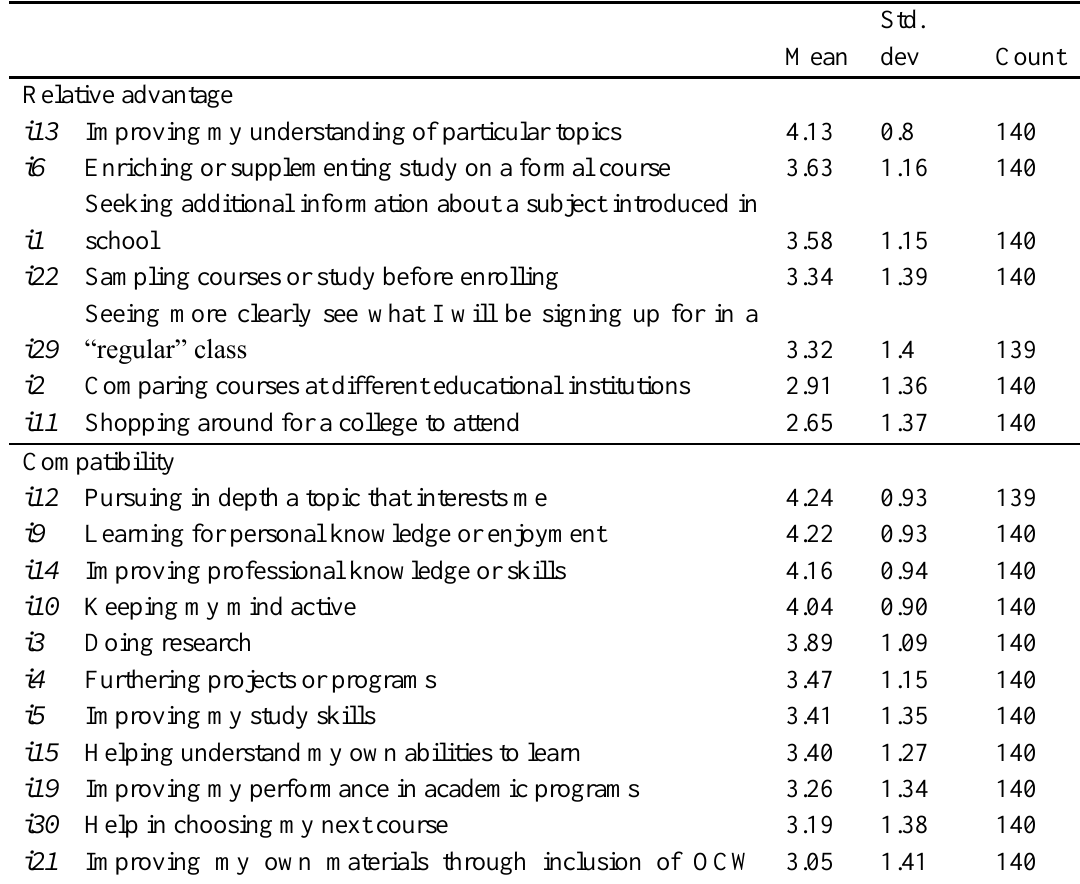
Descriptive Statistics of Responses for Incentives by Rogers’s Attributes of Innovation (N = 140)